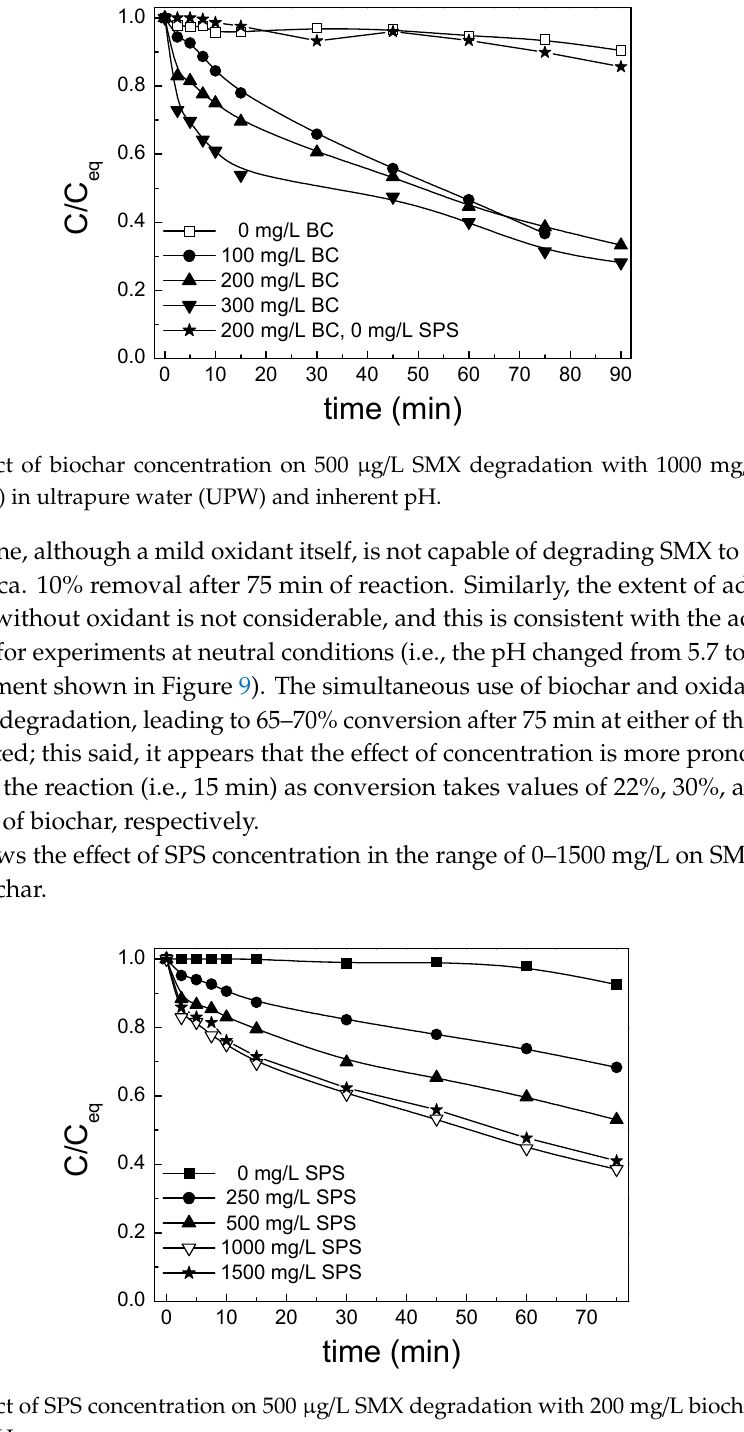
Figure 10. Effect of SPS concentration on 500 μ g/L SMX degradation with 200 mg/L biochar in UPW and inherent pH.